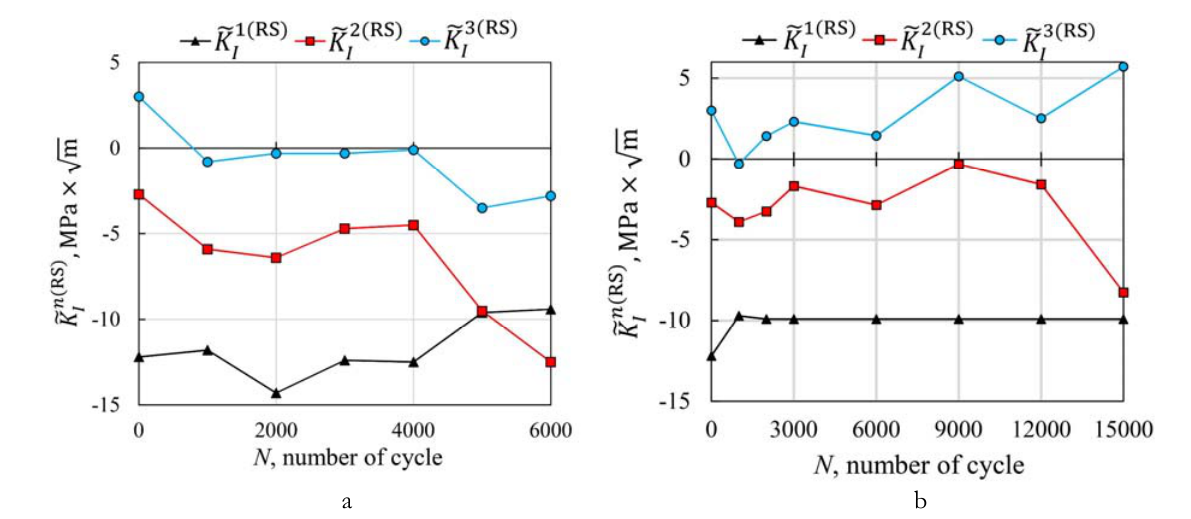
a b   1 RS K values as a function of loading cycle number N for T5-H1 (a) and T5-H2 (b) specimens for notches of Figure 8: Residual SIF I a (n =1, 2, 3). length  n